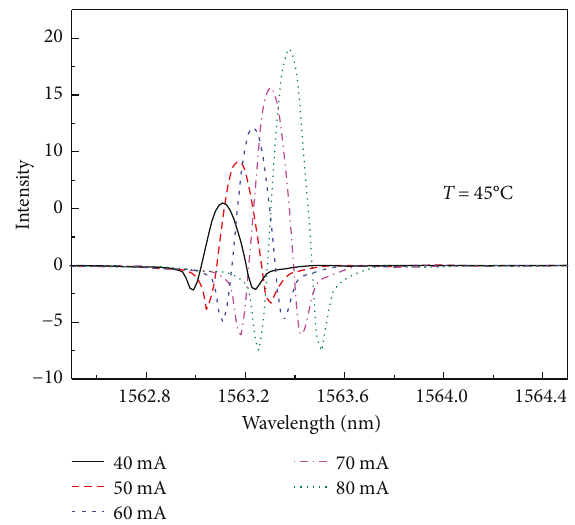
Figure 5: Under constant laser temperature, the center wavelength and optical power are controlled by injection current.